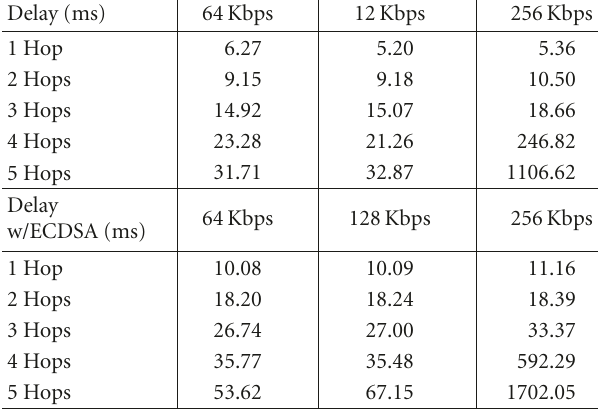
Table 9: Delay both with and without data authentication Unicast routing, autoconfiguration, Real-Time, and PACP are active.